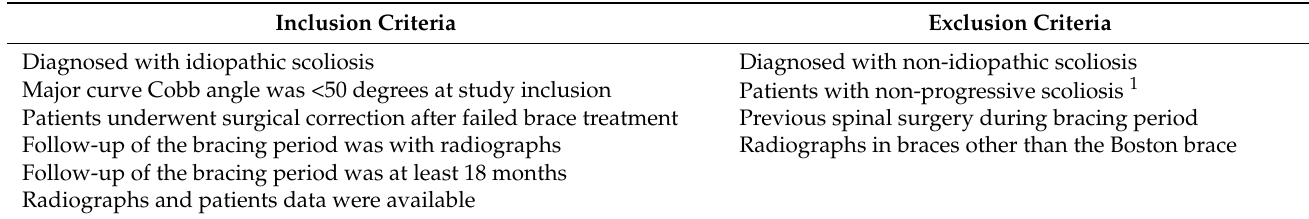
Table 1. Patient